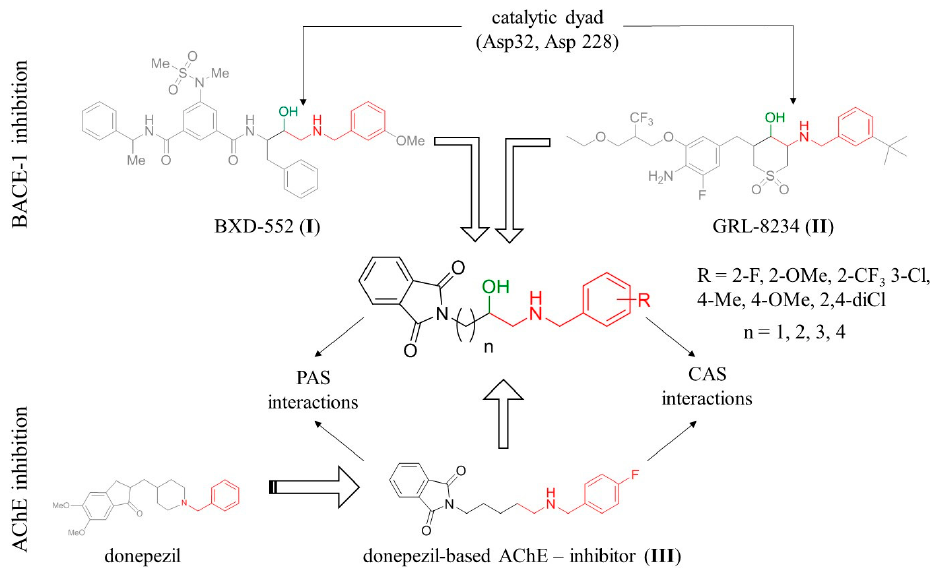
Figure 1. Design strategy for multitarget anti-Alzheimer’s agents. CAS: catalytic anionic site, PAS: peripheral anionic site.